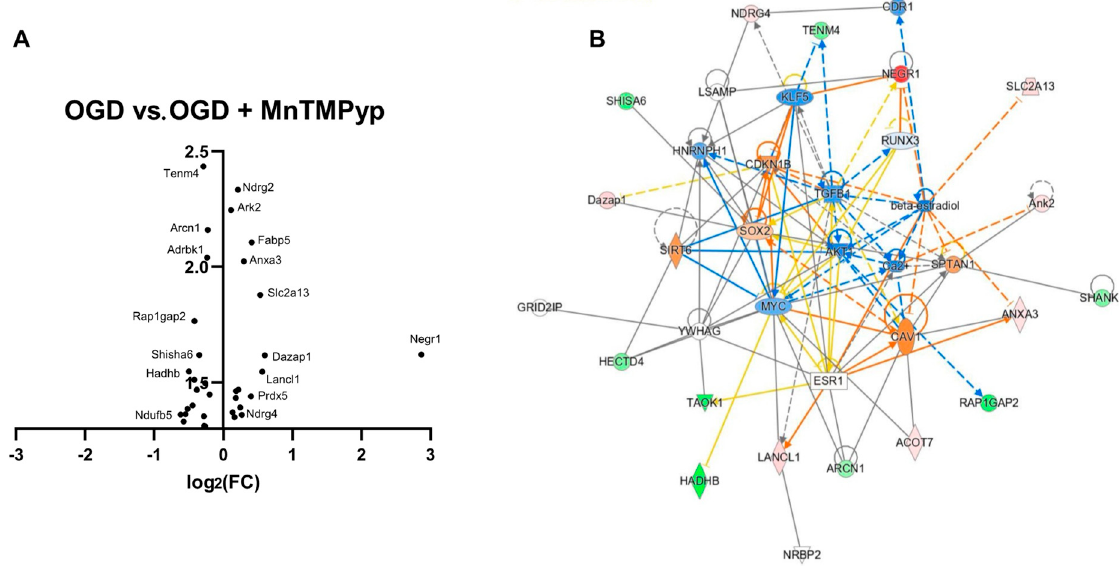
Figure 8. Application of MnTMPyP modulates synaptogenesis and mitochondrial oxidative phosphorylation following OGD. ( A ) Volcano plot of differentially expressed targets shows the most dramatic upregulation (log2(Fold Change) > 2) of Negr1, responsible for axon growth. The most significant hits include downregulation of Tenm4 (axonal myelination) and upregulation of Ndrg2 (neurite outgrowth). ( B ) The most enriched network ( p = 1.00 × 10 − 42 ) is centred around downregulation of TGFB1, a growth factor with roles in proliferation, differentiation and growth, in addition to actin dynamics and mitochondrial activity. Other central nodes include CDKN1B, a regulator of cell cycle, and downregulation of beta-oestradiol, with reported neuroprotective